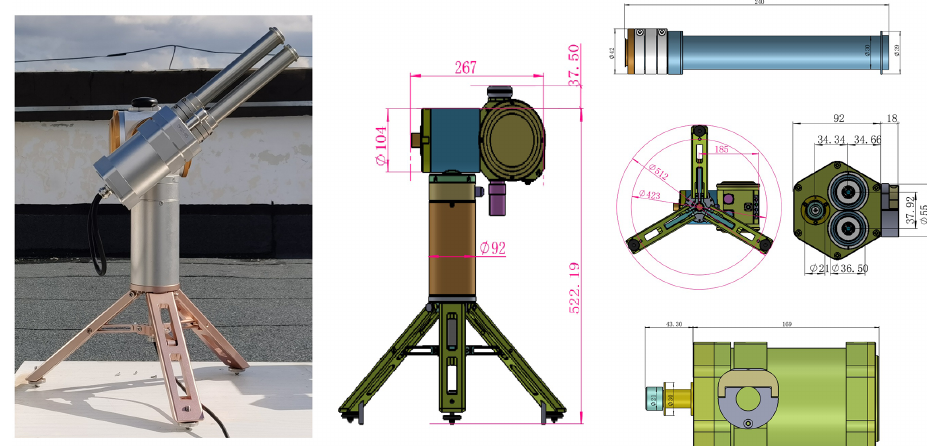
Figure 2. CW193 scheme and